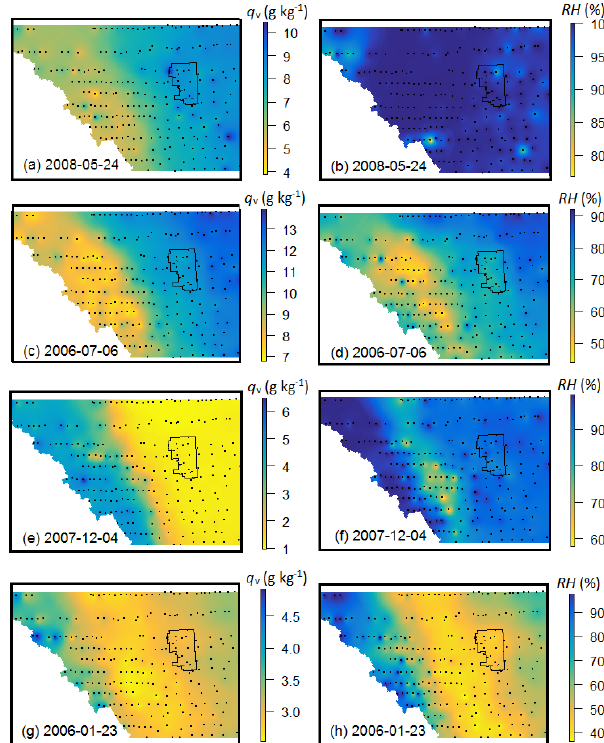
Figure 7. Examples of daily specific (a, c, e, g) and rela- tive (b, d, f, h) humidity structure in the study area. (a, b) A cy- clonic precipitation event on 24 May 2008. (c, d) A day with after- noon thunderstorm activity on 6 July 2006. (e, f) A continental polar air mass over the study area on 4 December 2007. (g, h) Chinook conditions on 23 January